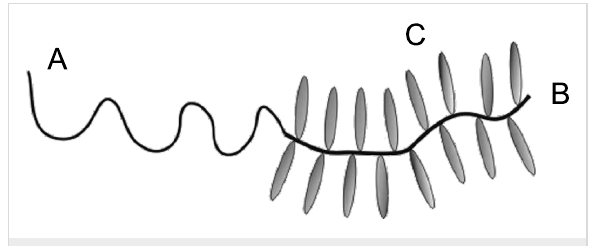
Figure 2: Schematic representation of coil–LC comb